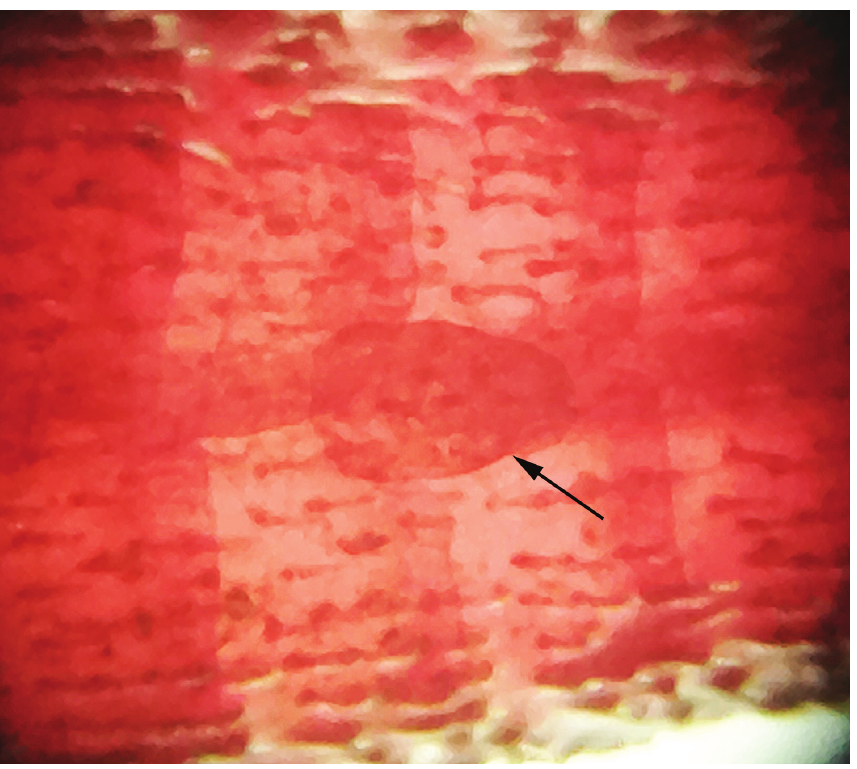
Figure 3. Picture showing (arrow) the single dorsal plate in the caudal peduncle at typical adipose-fin region of Parotocinclus dani , LBP 22089, 27.3 mm